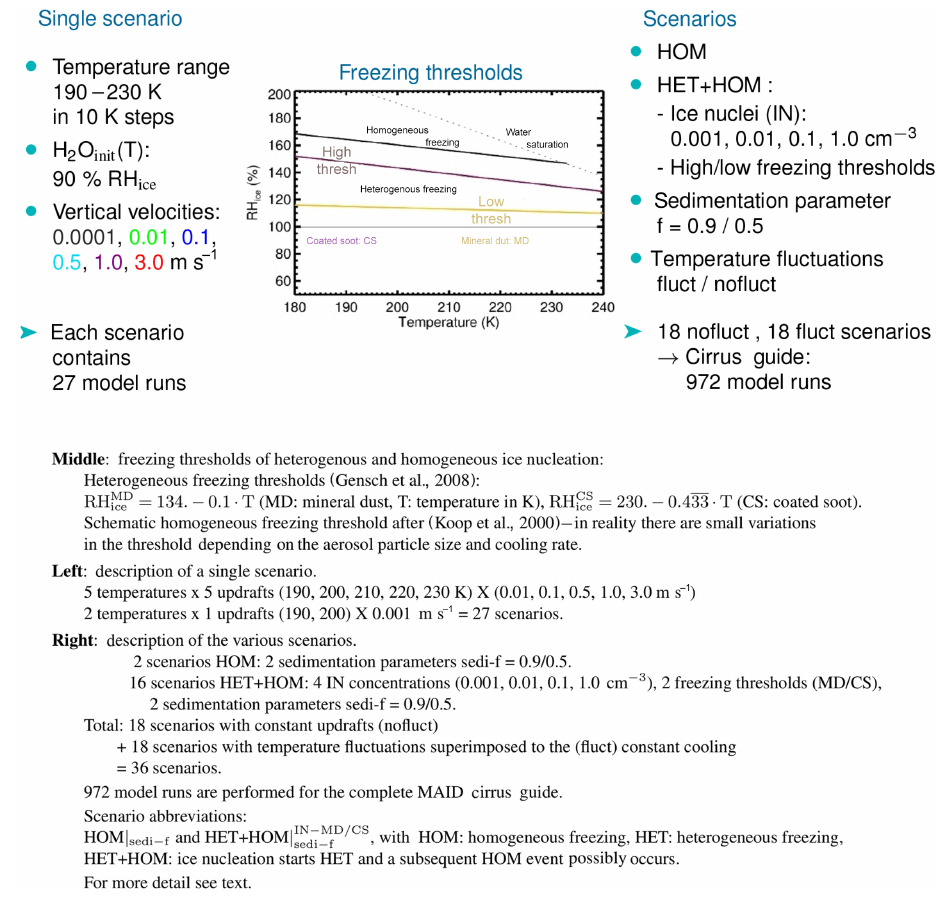
Figure 4. Description of the MAID Cirrus Guide